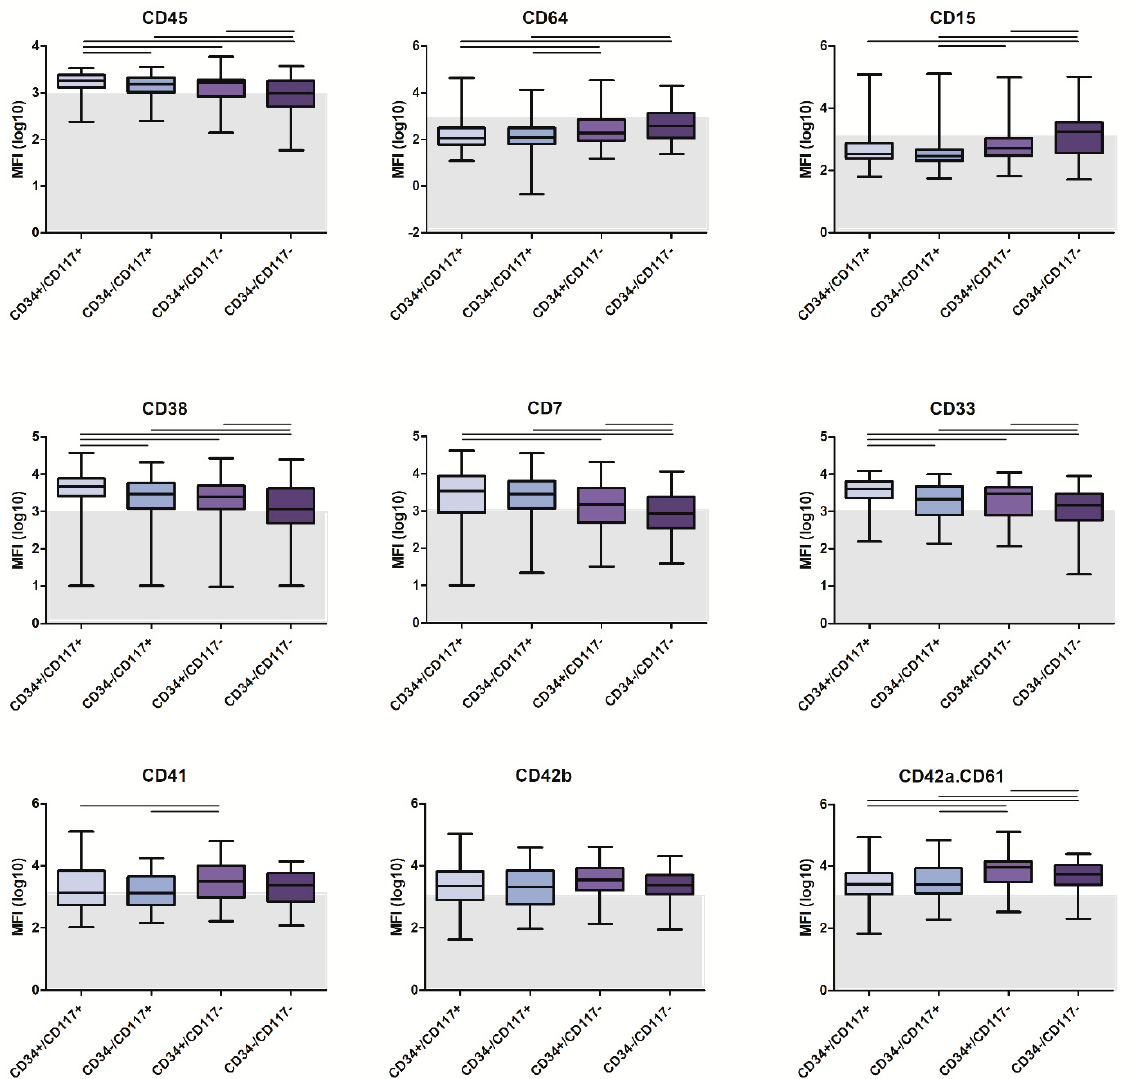
Figure 3. Immunophenotypic profile of CD34+/CD117+, CD34 − /CD117+, CD34+/CD117 − or CD34 − /CD117 − subsets of AMKL cells. Expression of markers is depicted as log10 transformed MFI data. Statistical analysis was performed by the Kruskal–Wallis test, followed by the Mann–Whitney test if p < 0.05. The horizontal lines between populations represent statistically significant differences ( p < 0.05). The grey zone indicates MFI levels < 1000; markers with such MFI values were considered to be negative.